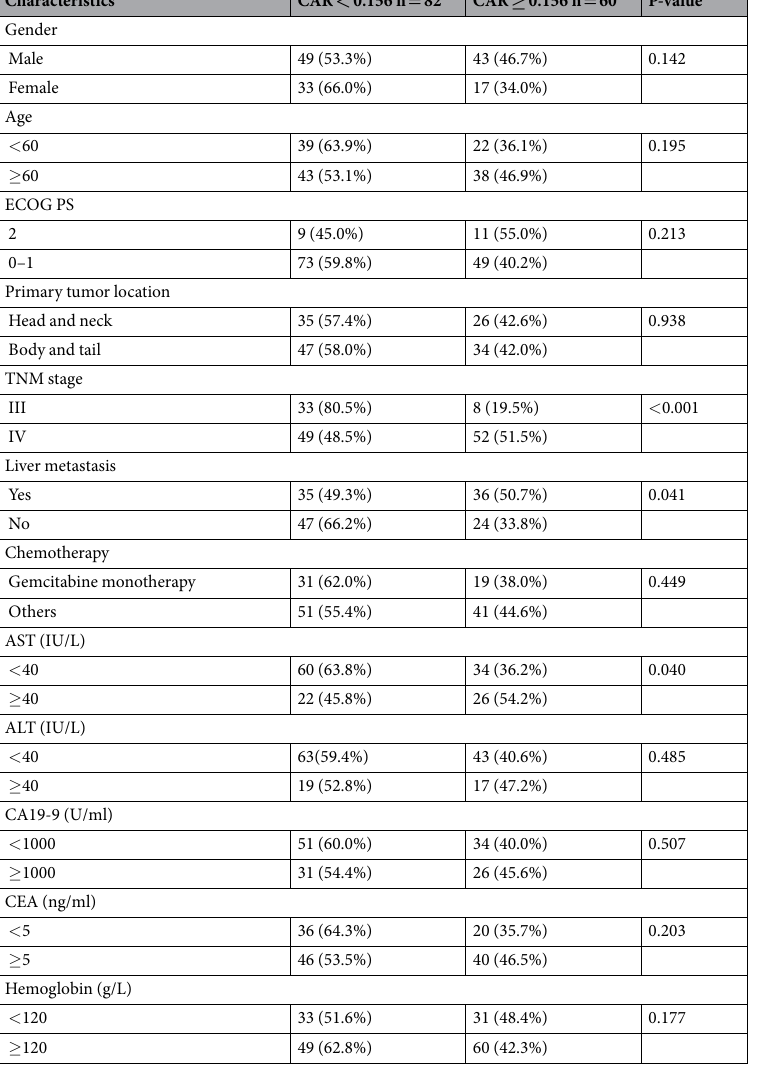
Table 2. Baseline clinicopathological characteristics according to CAR.